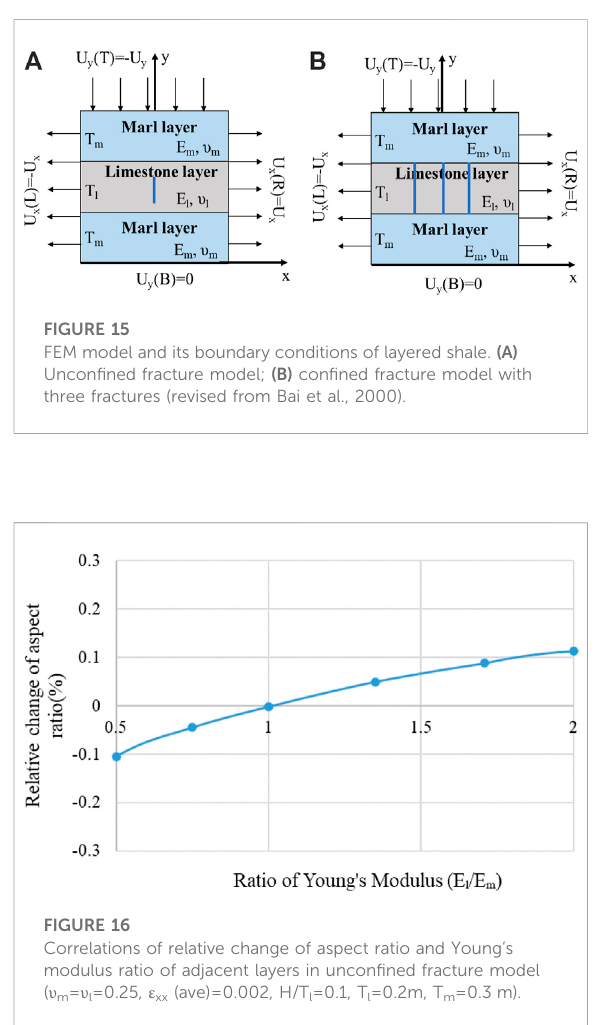
FIGURE 18 Correlations of relative change of aspect ratio and Young ’